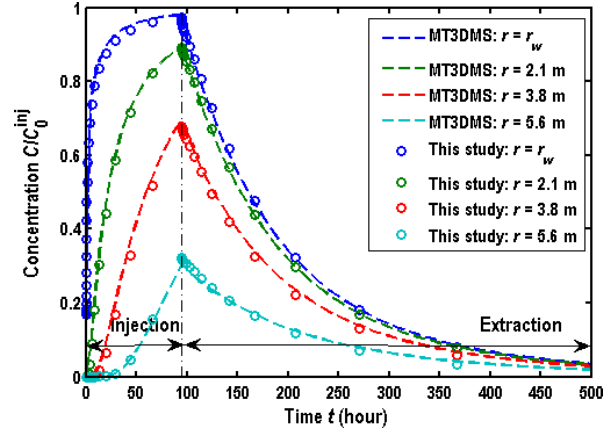
Figure 3. Comparison of BTCs between the solutions of MOD- FLOW/MT3DMS and of this